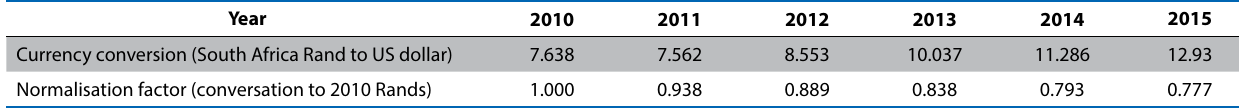
Table 2. Values for exchange rates and normalisation factors